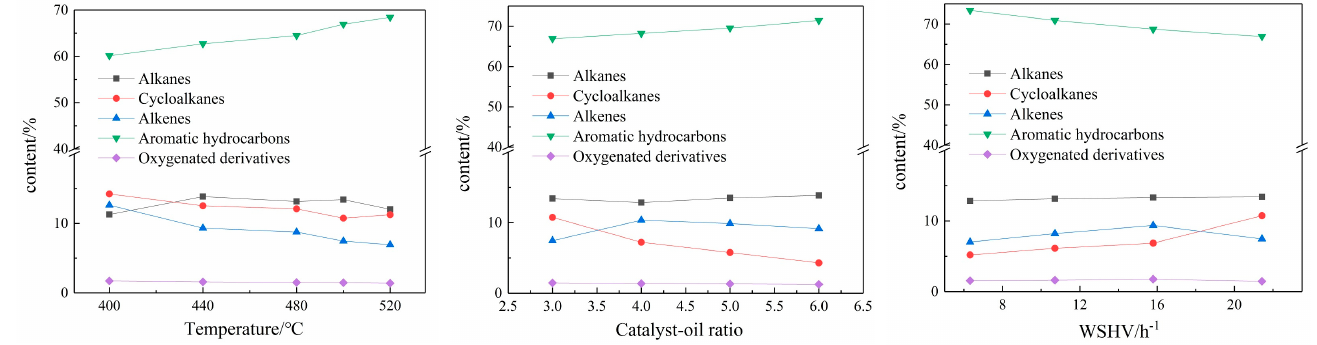
Figure 4. Relative contents of each compound of the gasoline fraction.